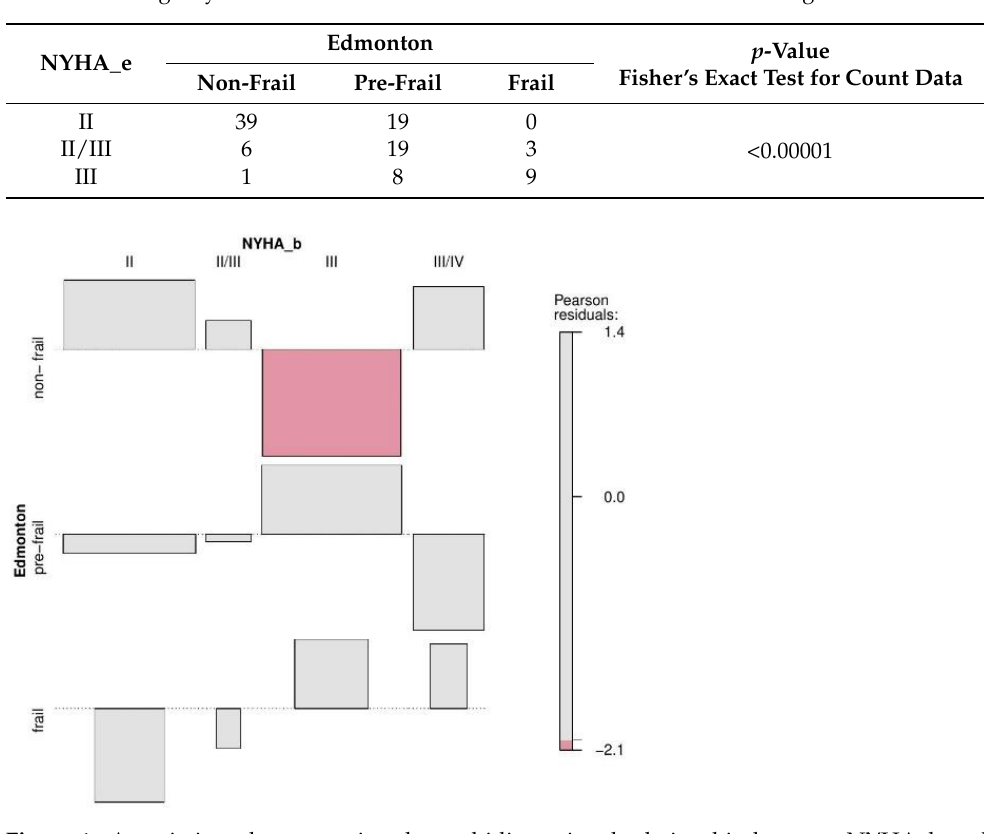
Figure 1. Association plot presenting the multidimensional relationship between NYHA_b and Edmonton subgroups.